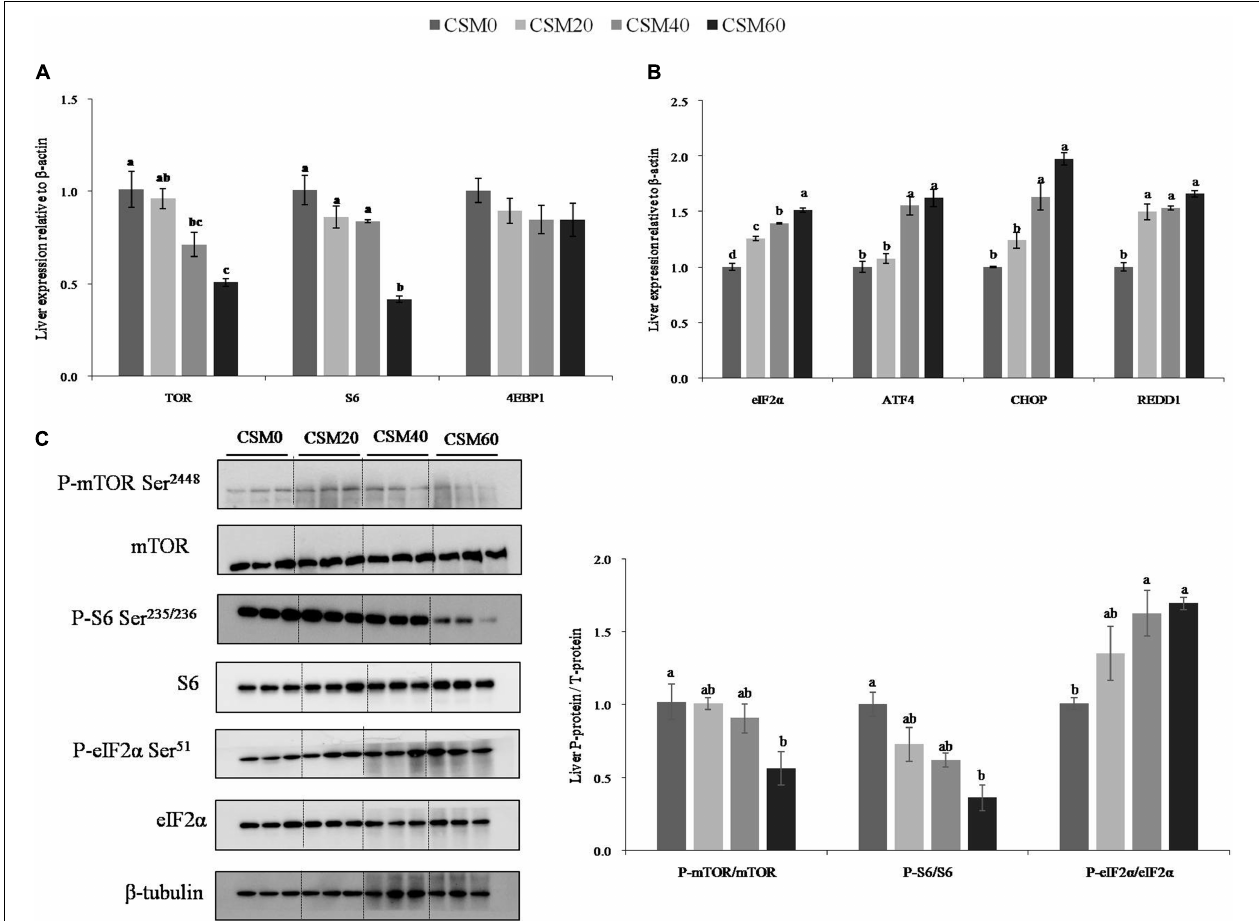
FIGURE 1 | The mRNA and protein phosphorylation level of key regulators in nutrient sensing signaling pathways (A) mRNA expression level of TOR signaling pathways. (B) mRNA expression level of AAR signaling pathway. (C) Protein phosphorylation level of TOR and AAR signaling pathways. In liver after juvenile golden pompano ( Trachinotus ovatus ) fed with CSM0, CSM20, CSM40, and CSM60 diets, respectively. Values with different superscripted small letters mean significant difference ( P < 0.05). TOR, target of rapamycin; S6, S6 Ribosomal Protein; 4EBP1, 4 E-binding protein 1; eIF2 α , initiation elongation factor alpha; ATF4, activating transcription factor 4; CHOP, channelopsin 2; REDD1, regulated in development and DNA damage responses